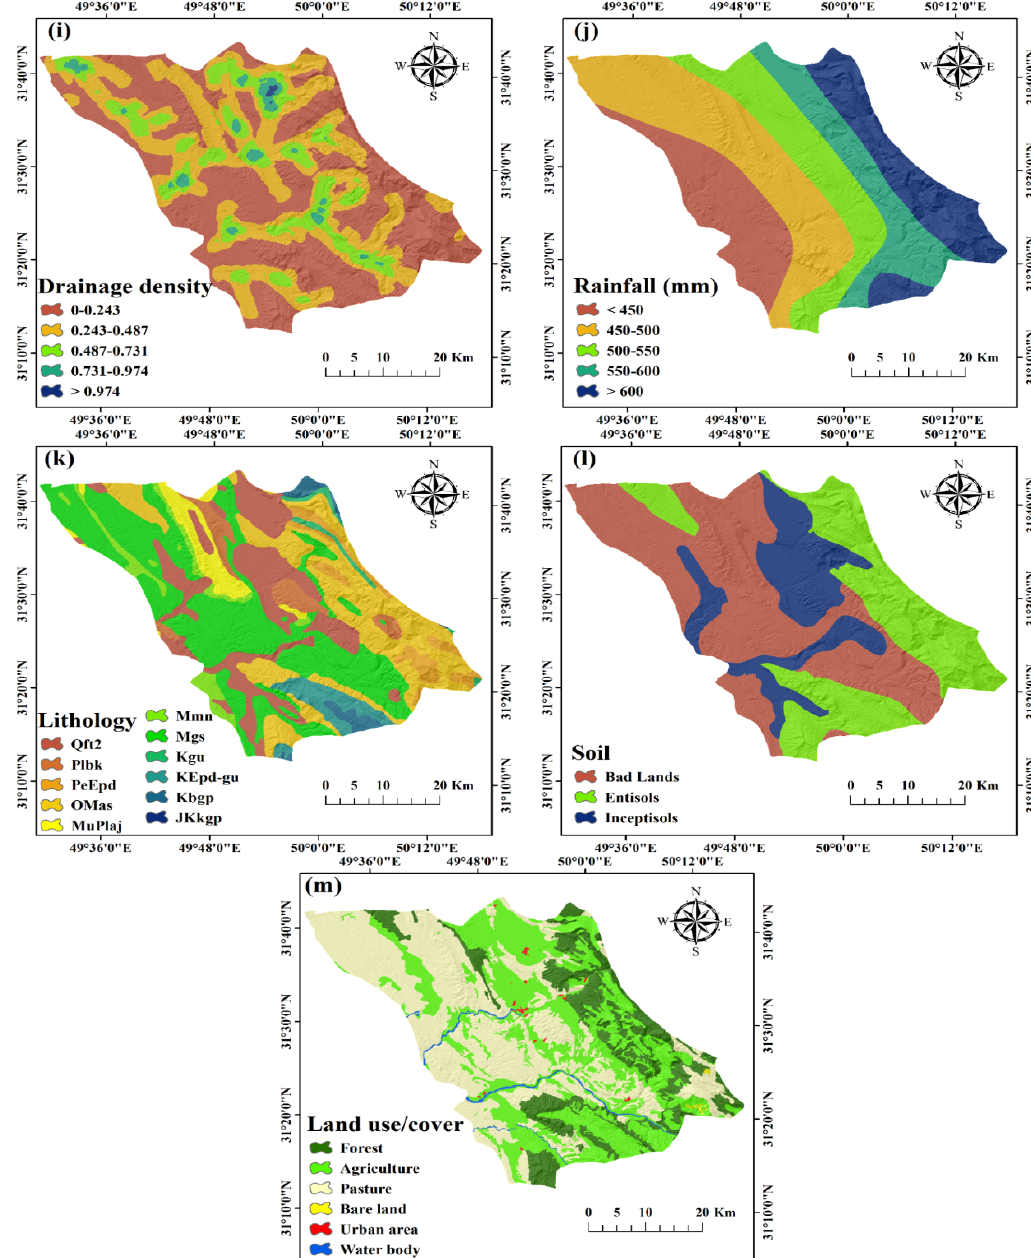
Figure 3. Maps of affecting factors: ( a ) altitude, ( b ) slope angle, ( c ) slope aspect, ( d ) topographic wetness index (TWI), ( e ) plan curvature, ( f ) profile curvature, ( g ) distance to river, ( h ) distance to fault, ( i ) drainage density, ( j ) rainfall, ( k ) lithology, ( l ) soil and ( m ) land use/cover.